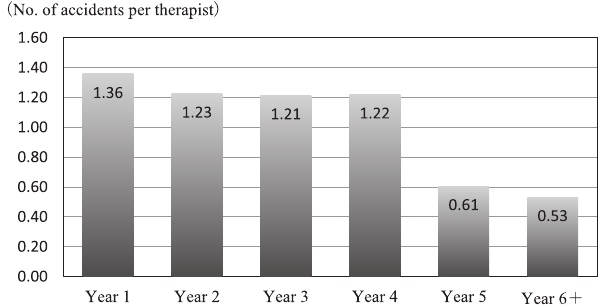
Figure 3 Annual number of accidents per therapist by years of experience. Patients tended to experience accidents when the therapists helping or supervising them had 1–4 years of